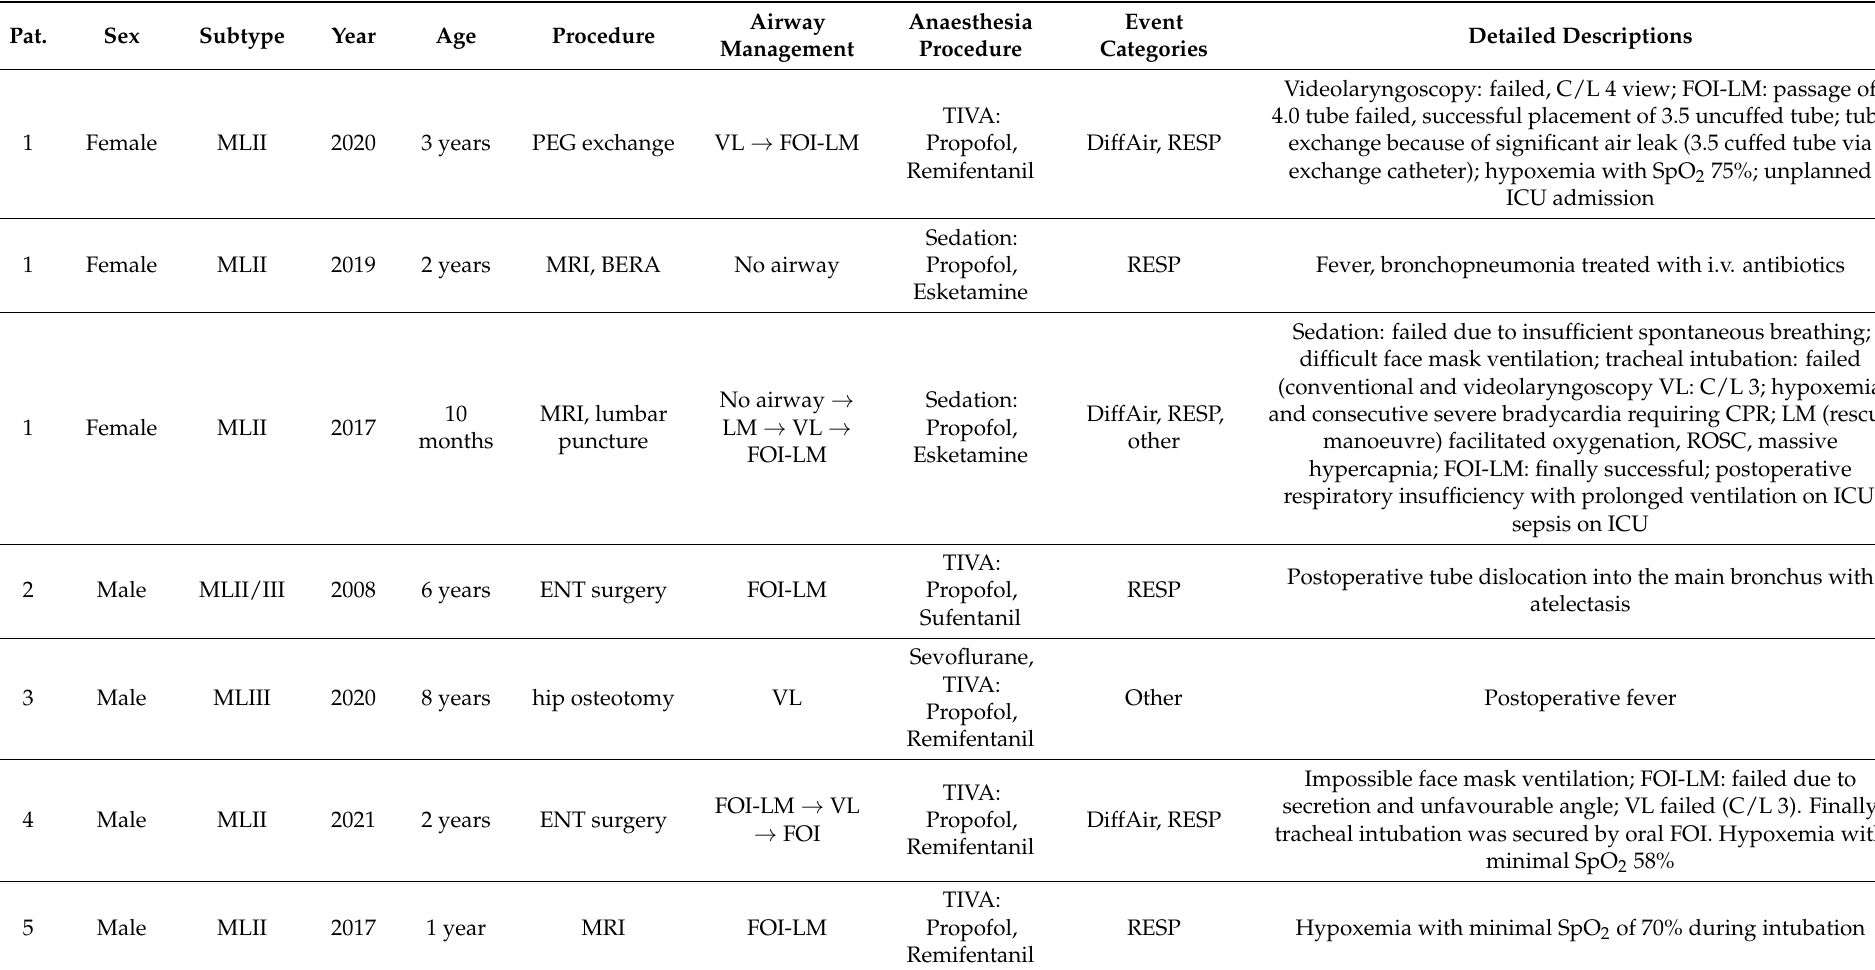
Table 4. Details of perianaesthetic complications in patients with